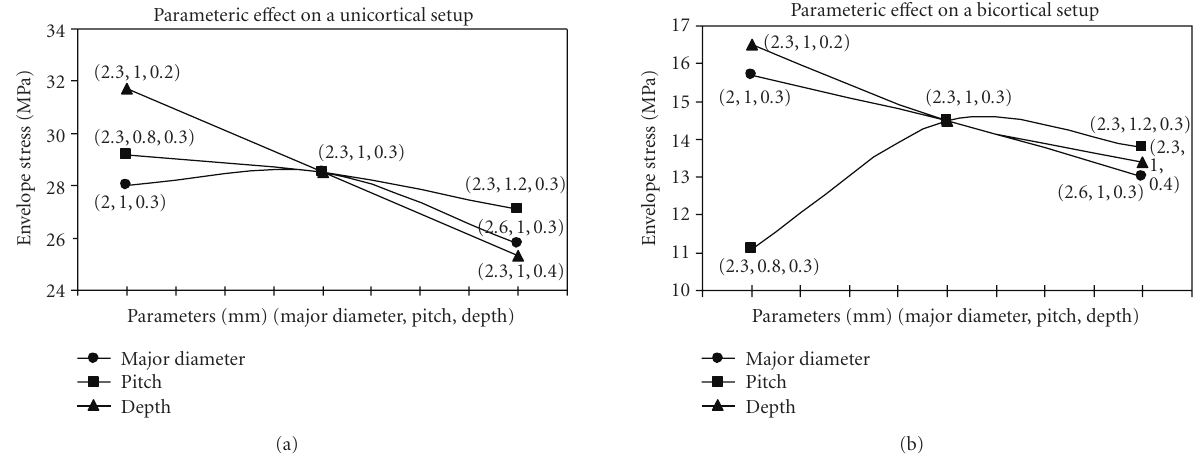
Figure 8: Plots showing the “envelope stress” for unicortical and bicortical setups.